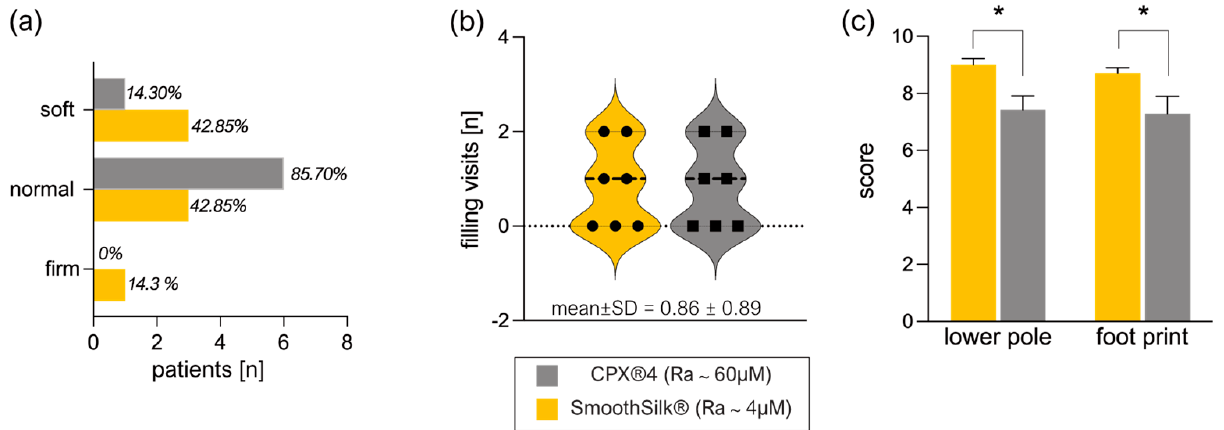
Figure 3. Intra–individual clinical evaluation of tissue expander performance after bilateral tissue expander-based breast reconstruction. Each patient received both types of expanders, the routinely used CPX ® 4 breast expanders (MENTOR ® , USA: surface roughness: ~60 µM Ra) and the novel surface-roughness reduced SmoothSilk ® breast expanders (Motiva Flora ® , Establishment Labs, Costa Rica: surface roughness: ~4 µM Ra) randomized to the left or right breast after bilateral prophylactic NSME. ( a ) Evaluation of expander palpation 2 W, 4 W, and 16 W post-op. ( b ) Number of filling visits performed to full expansion of the device. ( c ) Surgeon satisfaction rating of tissue expander practicability 6–8 months post-op (lower pole: p * = 0.023, footprint: * p = 0.043; n = 7). Mean values ± SD of seven biological replicates (patients) are shown. The level for statistical significance was set at p ns > 0.05, * p < 0.05, ** p < 0.002, *** p < 0.0002, and **** p < 0.0001, for all statistical tests (inter- and intra-individual comparison; n = 7). Table 6) compared to the rougher CPX ® 4 device (lower pole: mean ± SD = 7.4 ± 1.3: footprint: mean ± SD = 7.3 ±